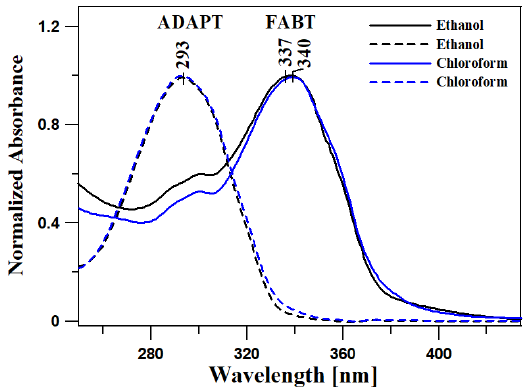
Figure 1. The electronic absorption spectra of the two compounds, FABT and ADAPT, registered in polar solvent—ethanol and non-polar solvent chloroform. polar solvent—ethanol and non-polar solvent chloroform.